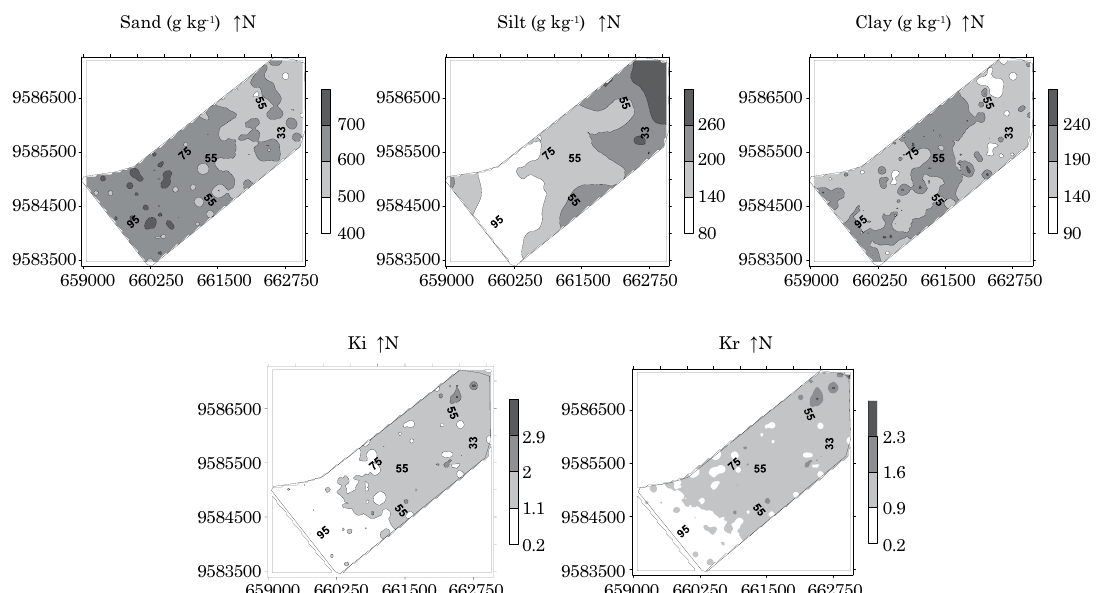
figure 4. Spatial pattern maps for the soil particle size and the weathering indices, in the agrarian reform